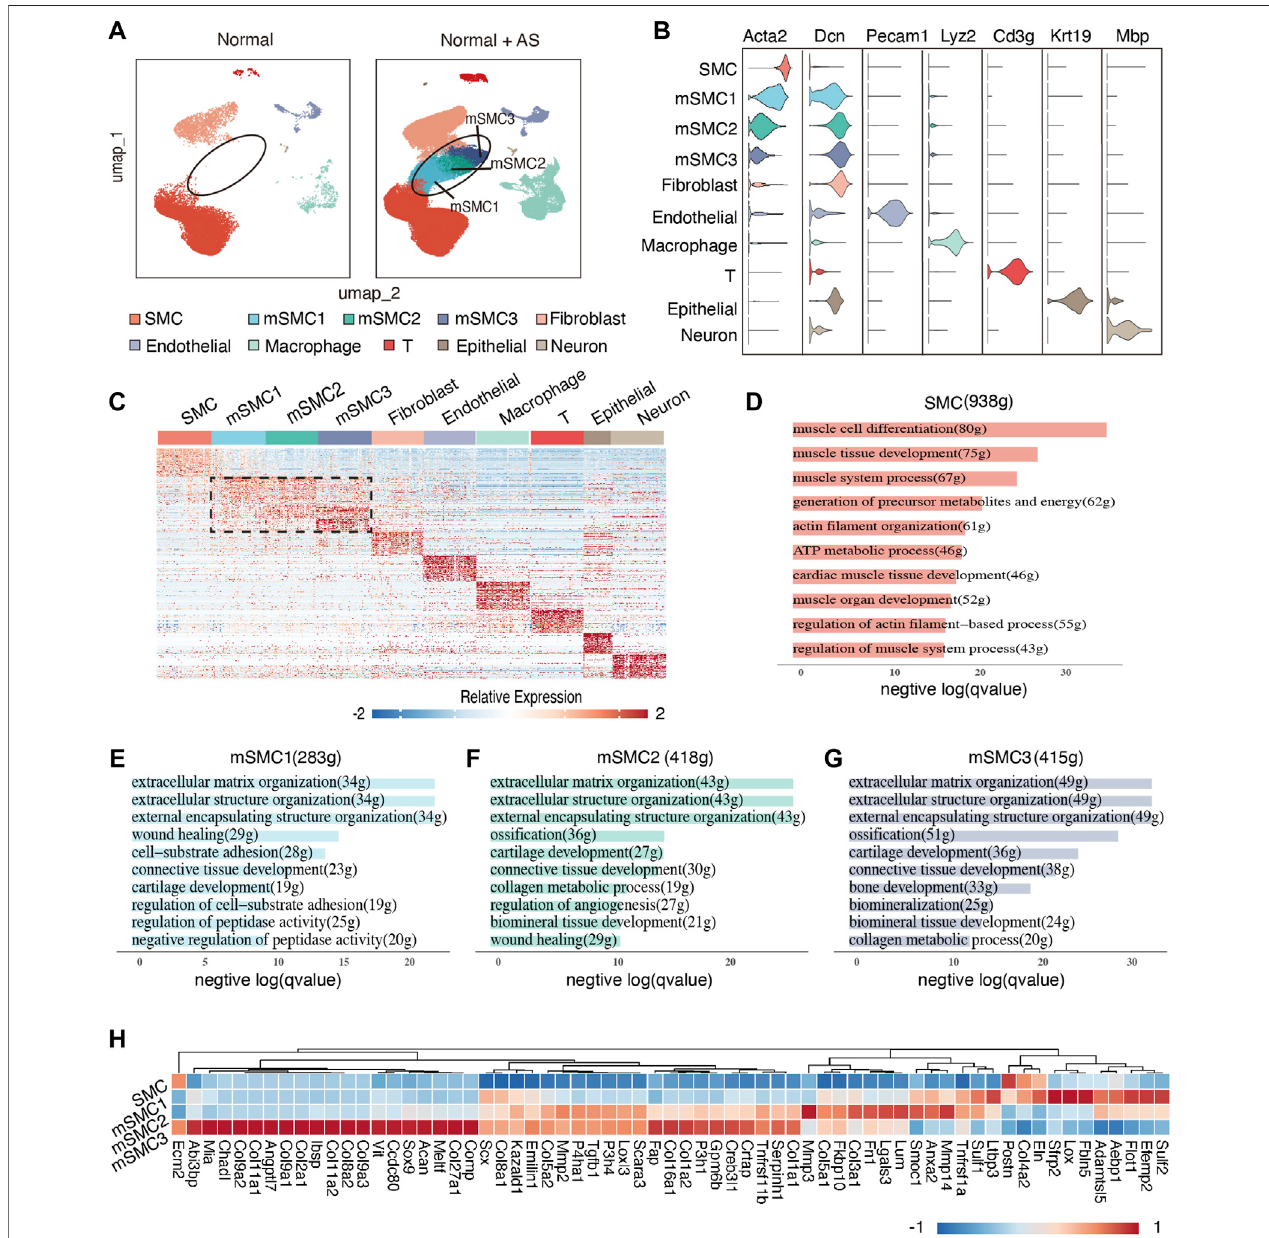
FIGURE 1 | Identi fi cation of cell types and functional characterization of each cell type in plaques in mice. (A) UMAP visualization of all cells (right) and cells from normal tissue (left). Normal tissue is de fi ned as aorta dissected from wild-type mice treated with a chow diet. (B) Violin plot of representative classic markers for each identi fi ed cell type. (C) Heatmap of top 100 DEGs for each cell type. Scaled log-normalized data were used for visualization. (D – G) Top 10 enriched GO biological processtermsforSMC,mSMC1,mSMC2,andmSMC3,respectively.ThenumberofDEGsforeachcelltypeandinvolvedgenesforeachGOtermwasdesignated in the brackets with g-representing genes. (H) Heatmap of genes enriched in an extracellular matrix organization in mSMC subtypes. Scaled log-normalized data were used for visualization. SMCs, smooth muscle cells; mSMCs, phenotypically modulated SMCs; DEGs, differentially expressed